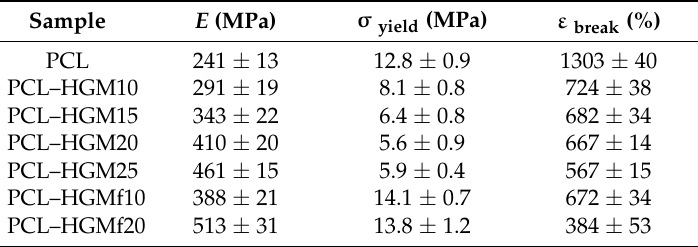
Figure 9. Stress–strain curves of PCL and selected PCL-based composites during monotonic tensile deformation. Table 4. Uniaxial tensile data for PCL and PCL-based composites.